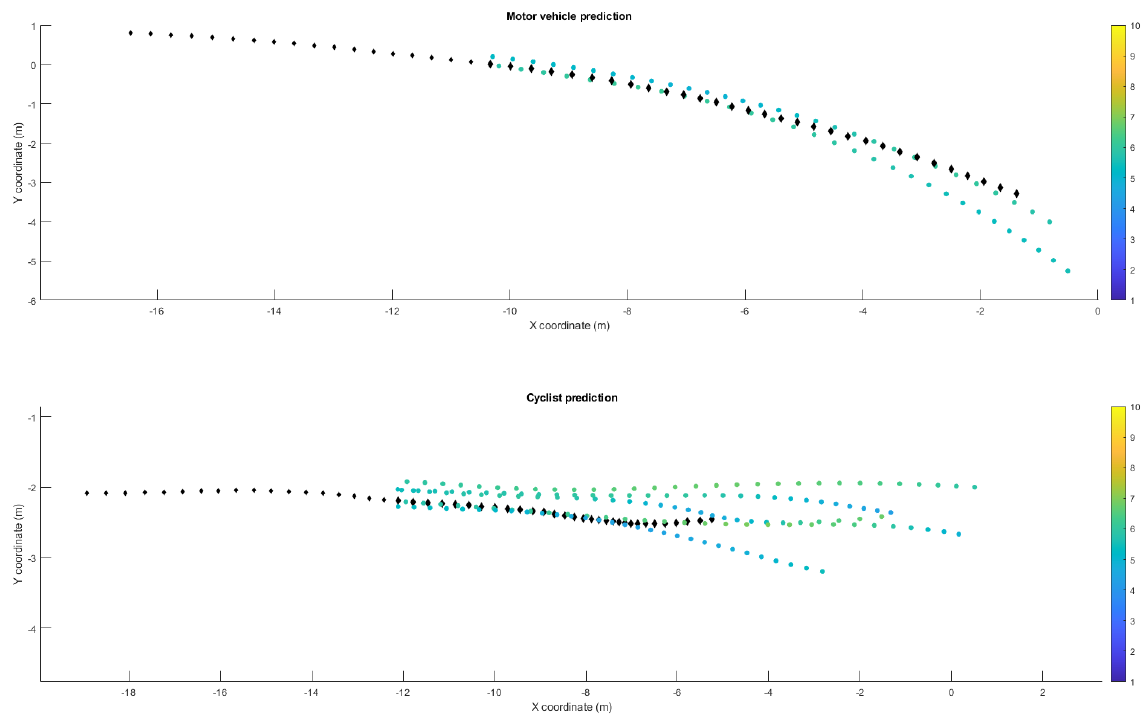
Figure 5 Motion prediction based on similar trajectories